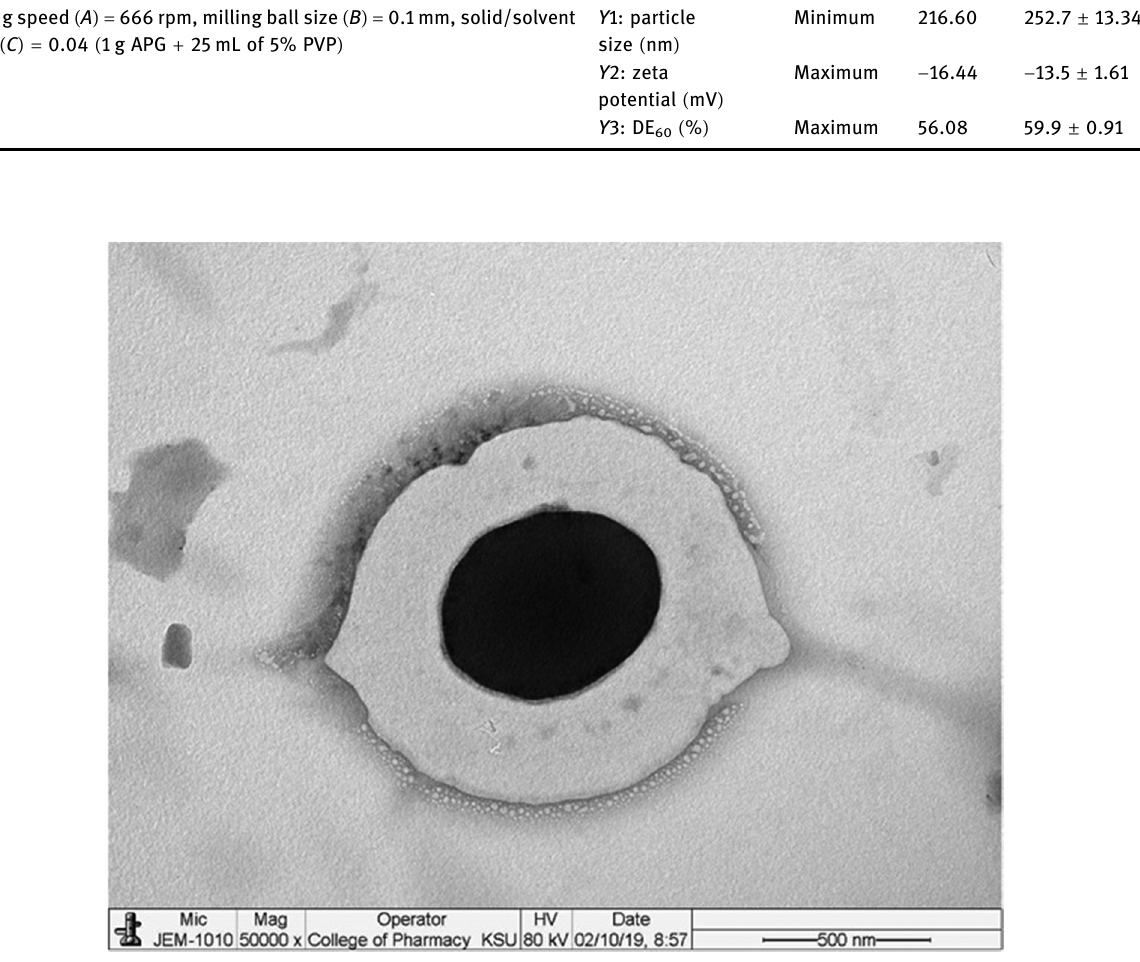
Figure 6: TEM images of optimized APG nanoparticle